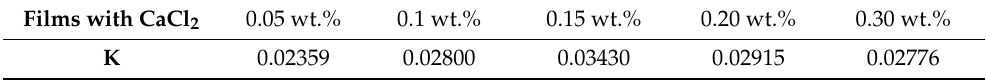
Table 2. The slope values of the linear fitting of input and output voltages. Films with CaCl